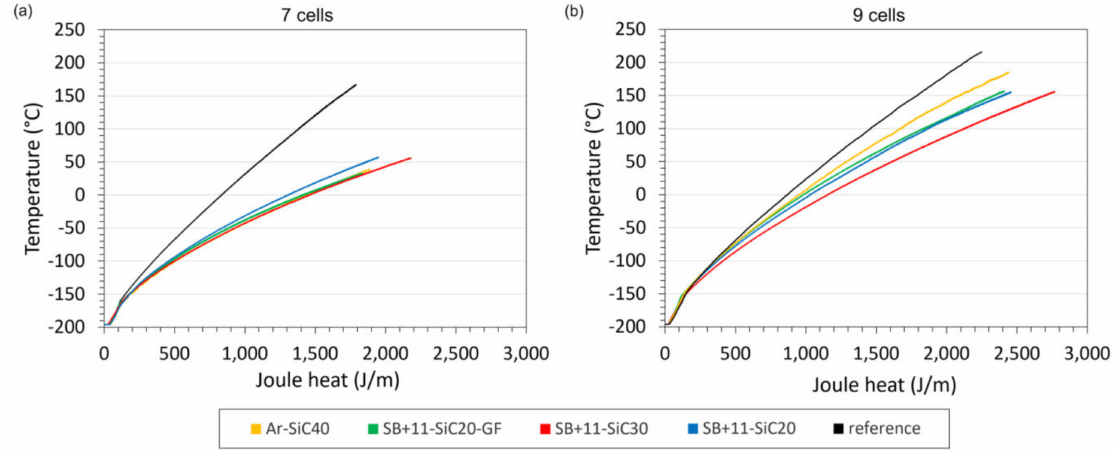
Figure 11. Dependence of temperature on Joule heat generated in the CC tapes during limitation experiment with 50 ms DC pulse and di ff erent electric fields 7 ( a ) and 9 cells ( b